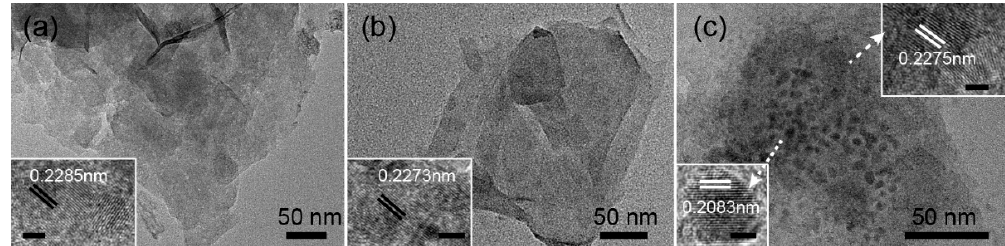
Figure 7. TEM images after photocatalytic reaction ( a ) NiAl–LDH films, ( b ) Fe-doped NiAl–LDH films, and ( c ) Fe-doped NiAl–LDH films in the presence of 5 mg·L − 1 Ag ions. Insets are corresponding HRTEM images. Scales in insets are 2 nm.